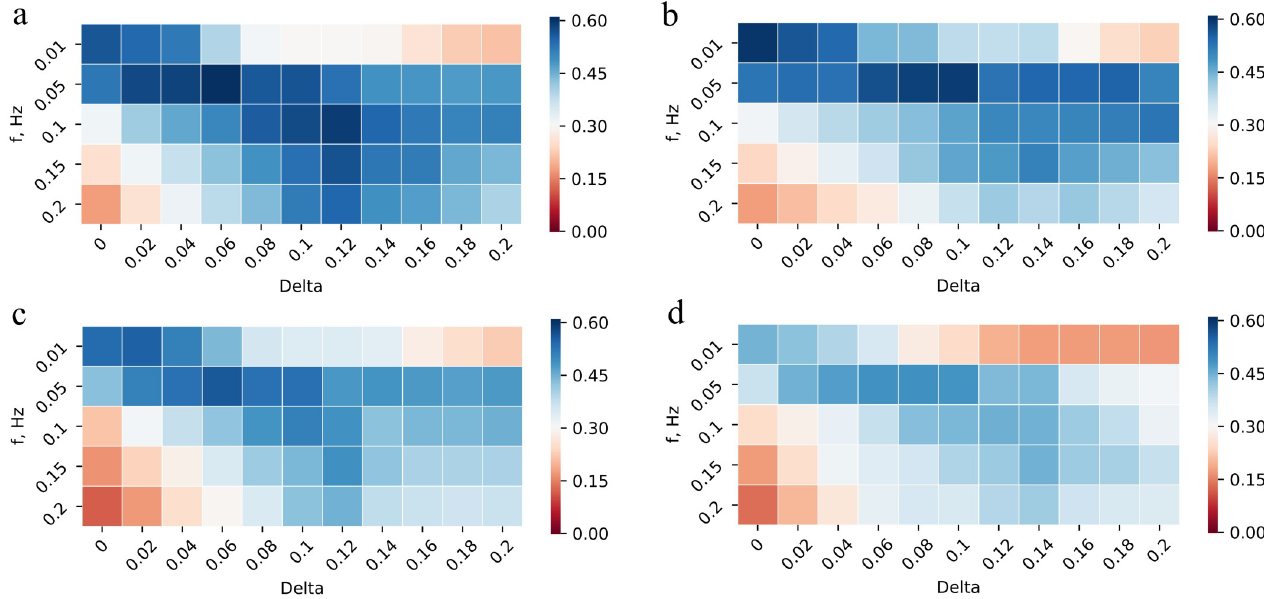
Fig 9. H value for different methods. A) Method A: all types of pupil changes in terms of size and difficulty on the pupil signal on Dataset A. B) Method B: all types of pupil changes in terms of size and difficulty on the difference signal on Dataset A. C) Method C: obvious pupil changes of any size on the pupil signal on Dataset A. D) Method D: all types of pupil changes in terms of size and difficulty on the pupil signal on Dataset B.